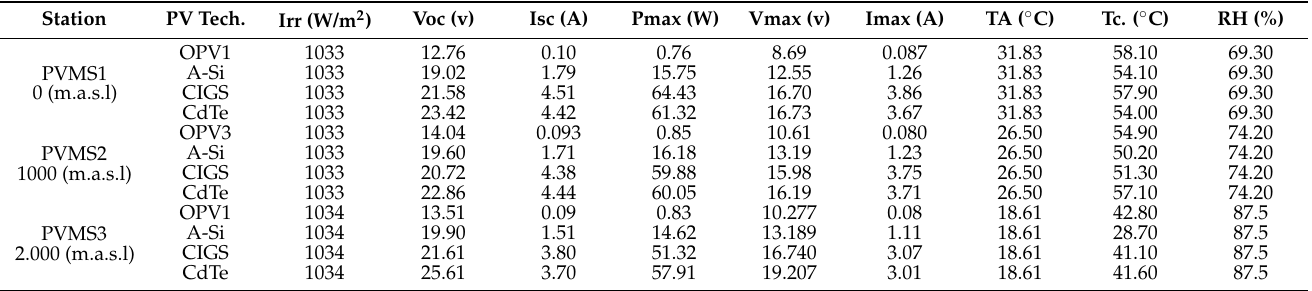
Table 2. PV and meteorological parameters measured for each PV technology placed in